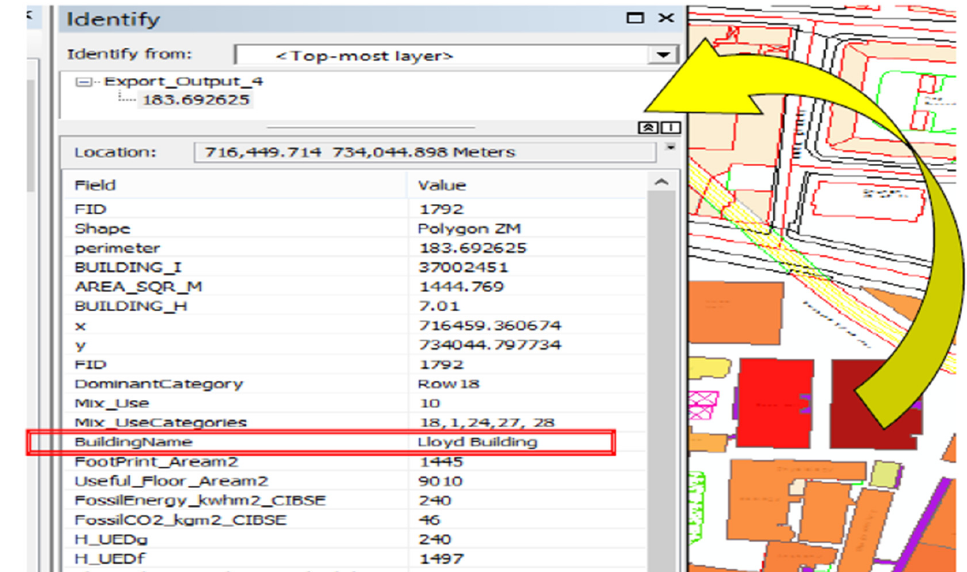
Figure 3. Screenshot of attribute table of DHB tool, energy and building